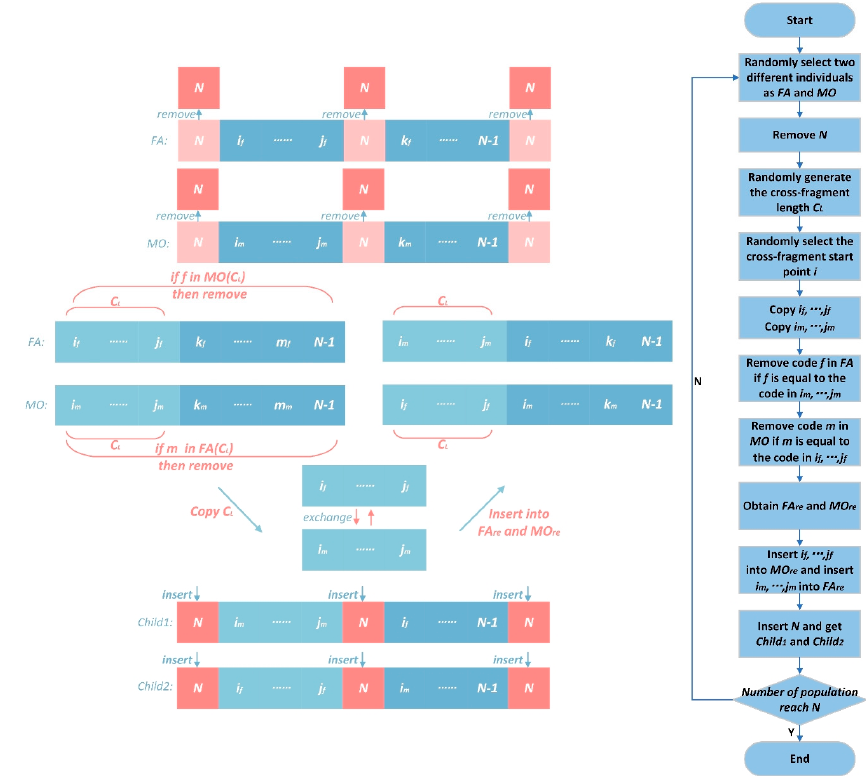
Figure 7. The schematics and the flowchart of the crossover